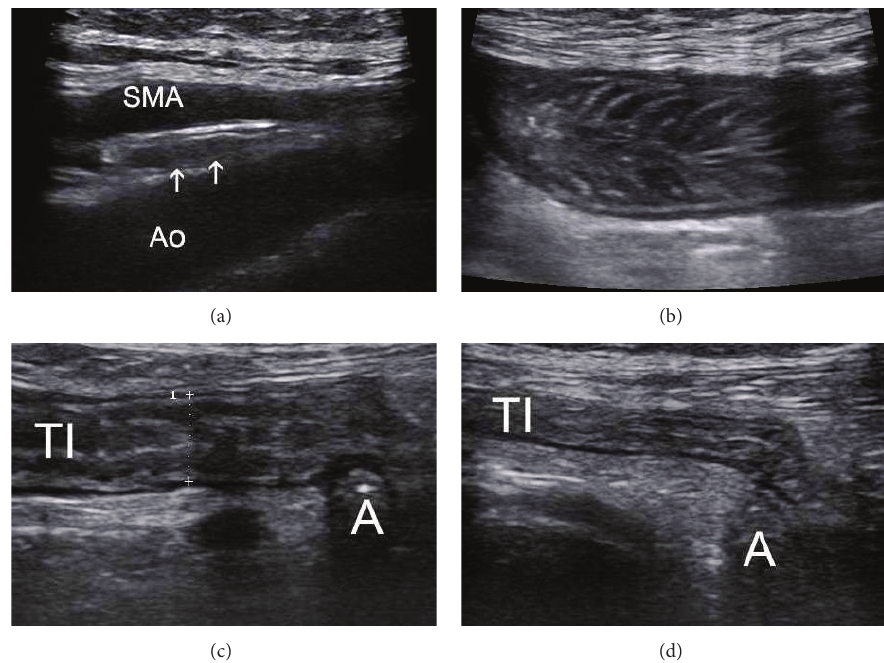
Figure 1: Normal small bowel: (a) Transverse view of pars horizontalis duodeni between aorta and SMA. (b) Longitudinal view of jejunum in left mesogastrium—with numerous valvulae conniventes. (c) Longitudinal section of terminal ileum (TI) in the left iliac fossa without and with compression by the probe (d). A—transverse view of appendix. All with high resolution probe